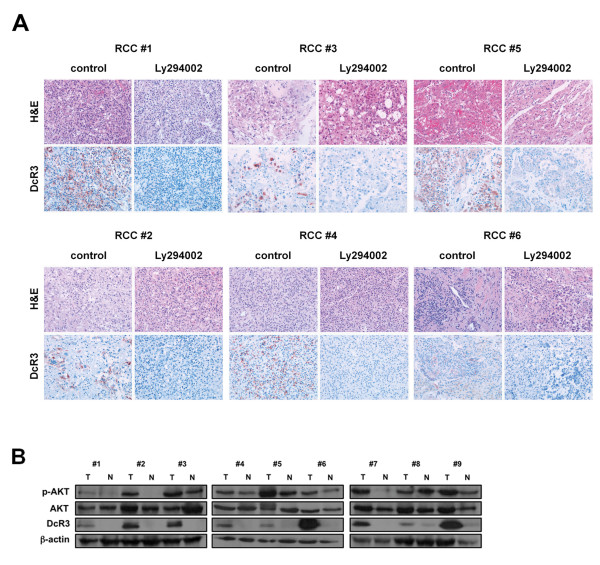
DcR3 expression in human RCC specimens is PI3K/AKT-dependent. (A) Immunohistochemical analysis of DcR3 expression in ex vivo tissue samples 48 h after treatment with LY294002 (100 μM). Representative images are shown (magnification: 100×). (B) Immunoblot analysis of DcR3 and phospho-AKT protein levels in nine different pairs of RCC and respective normal renal tissue.